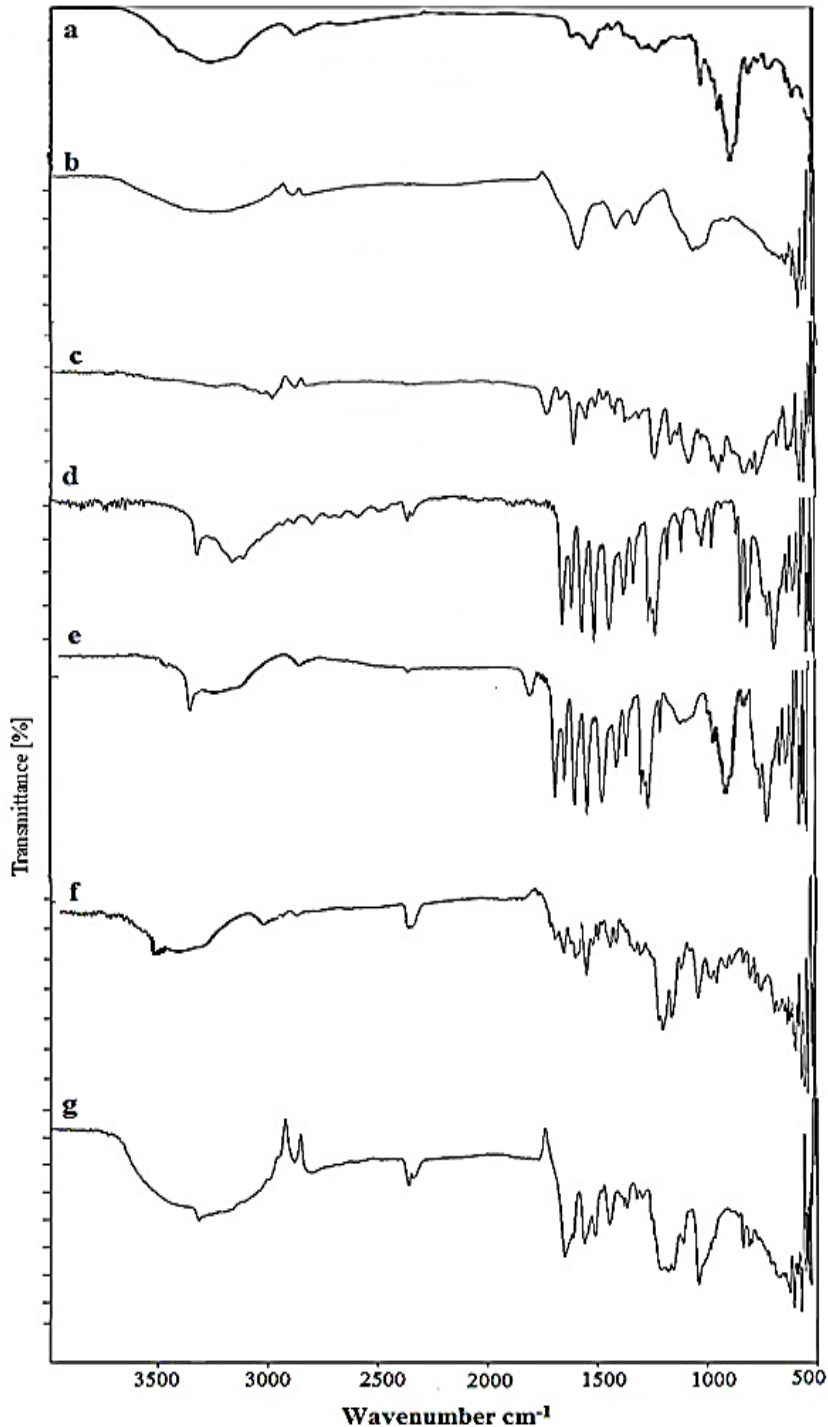
Figure 1. FTIR spectra of ( a ) pure drug docetaxel (DTX), ( b ) β -CD ( c ) Carboxymethyl chitosan (CMC), ( d ) AMPS, ( e ) physical mixture, ( f ) DTX loaded βCD -co-poly (AMPS), and ( g ) DTX loaded βCD -CMC-co-poly (AMPS) nanosponges.